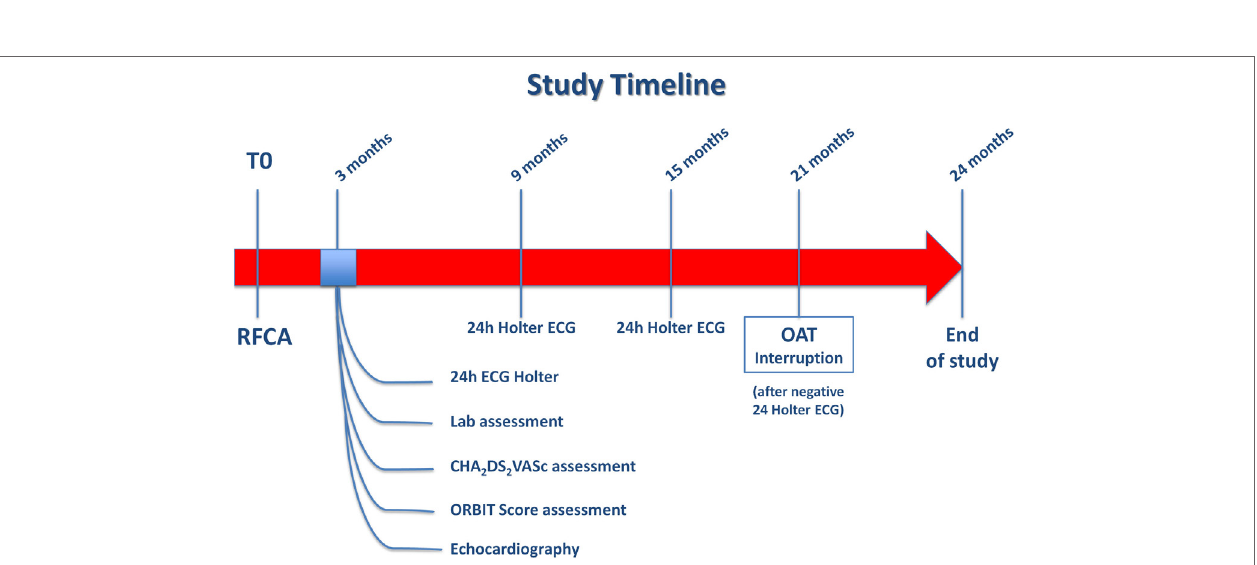
FiGUre 6 | Study timeline. Study related procedures in a